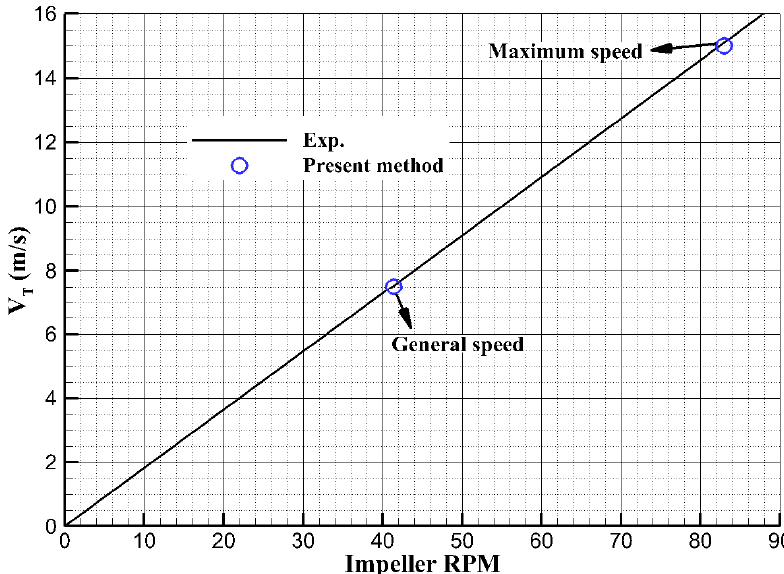
Figure 13. Test section speed according to the impeller RPM.